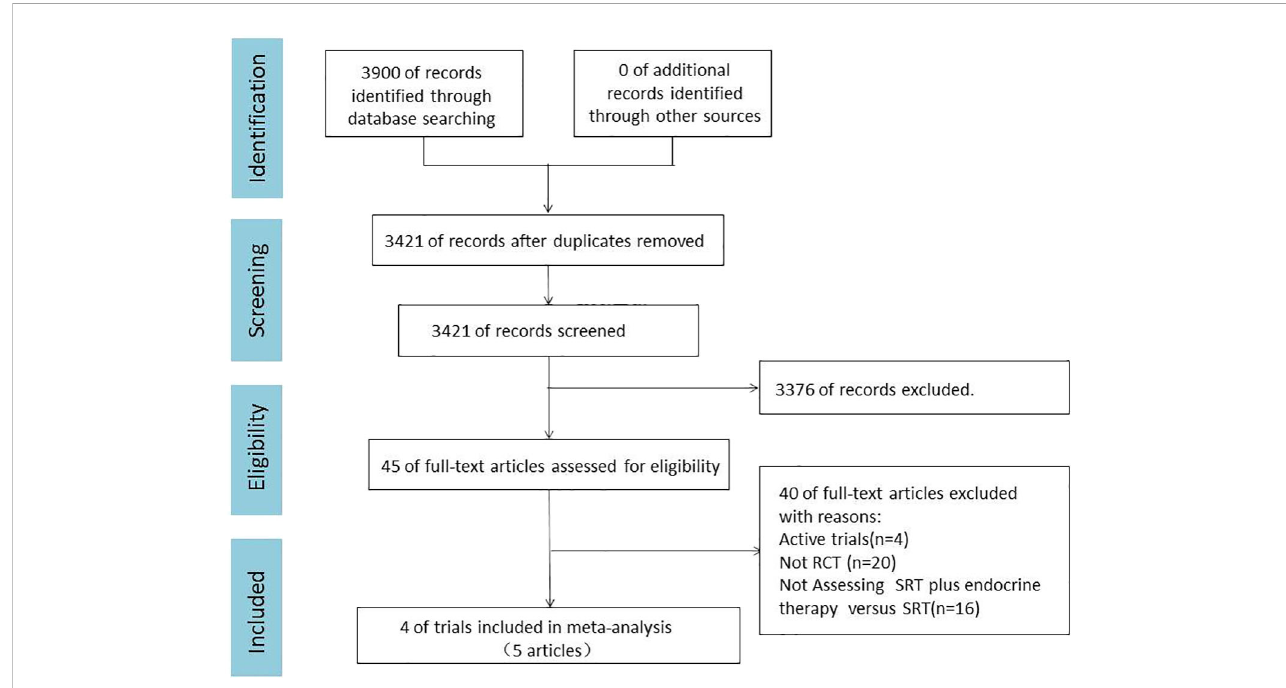
FIGURE 1 PRISMA Flow Diagram. RCT, randomized controlled trial; SRT, salvage